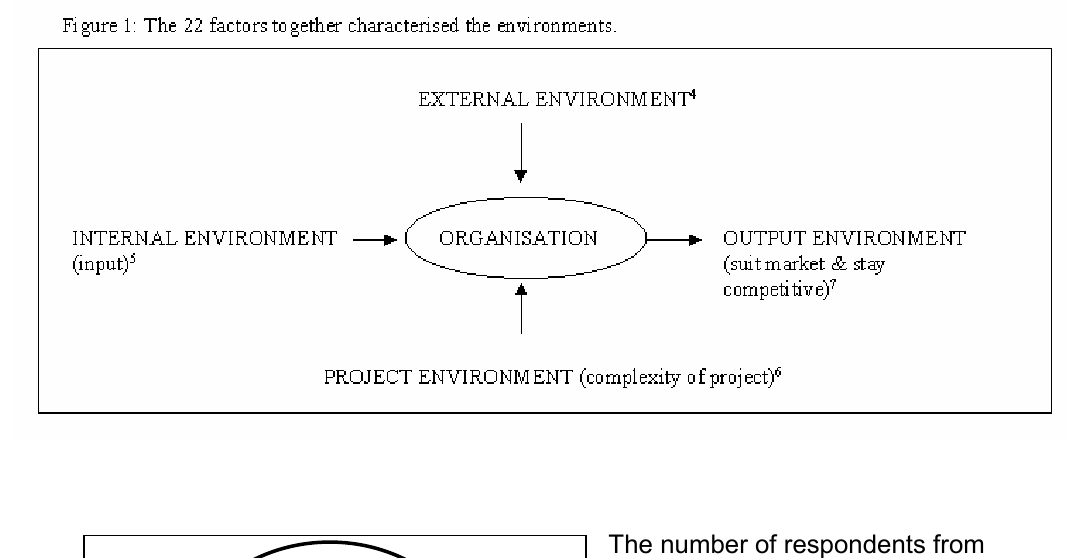
The number of respondents from each organisational niche is given in figure 2. The Chi sq. test showed statistically significant differences (at the .05 level) between the three single markets. The differences in ranking of importance of the 10 leading characteristics of the different markets are outlined below in Table 1. The pair-wise rank correlation tests were significant at the 0.01 level, which also indicates that the requirements for resources and skills are significantly different in the three markets.